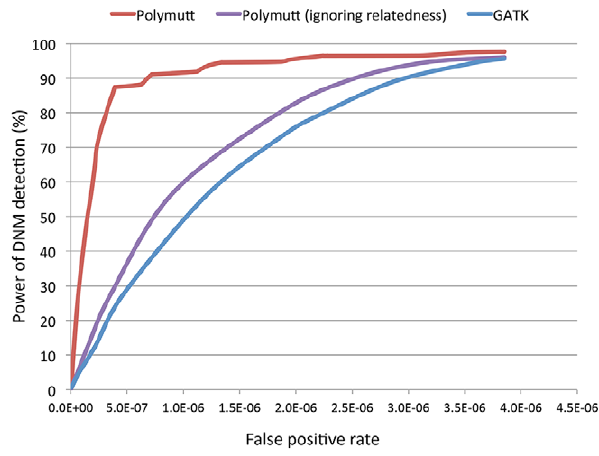
Figure 4. The receiver operating characteristic (ROC) curves of PolyMutt and the standard methods for de novo mutation (DNM) detection from empirically calibrated alignments of simulated reads with sequencing coverage of 30 6 with base quality of Q20. PolyMutt (ignoring relatedness) and GATK calls were obtained by jointly calling a trio assuming individuals in a trio are unrelated using Polymutt and GATK respectively.